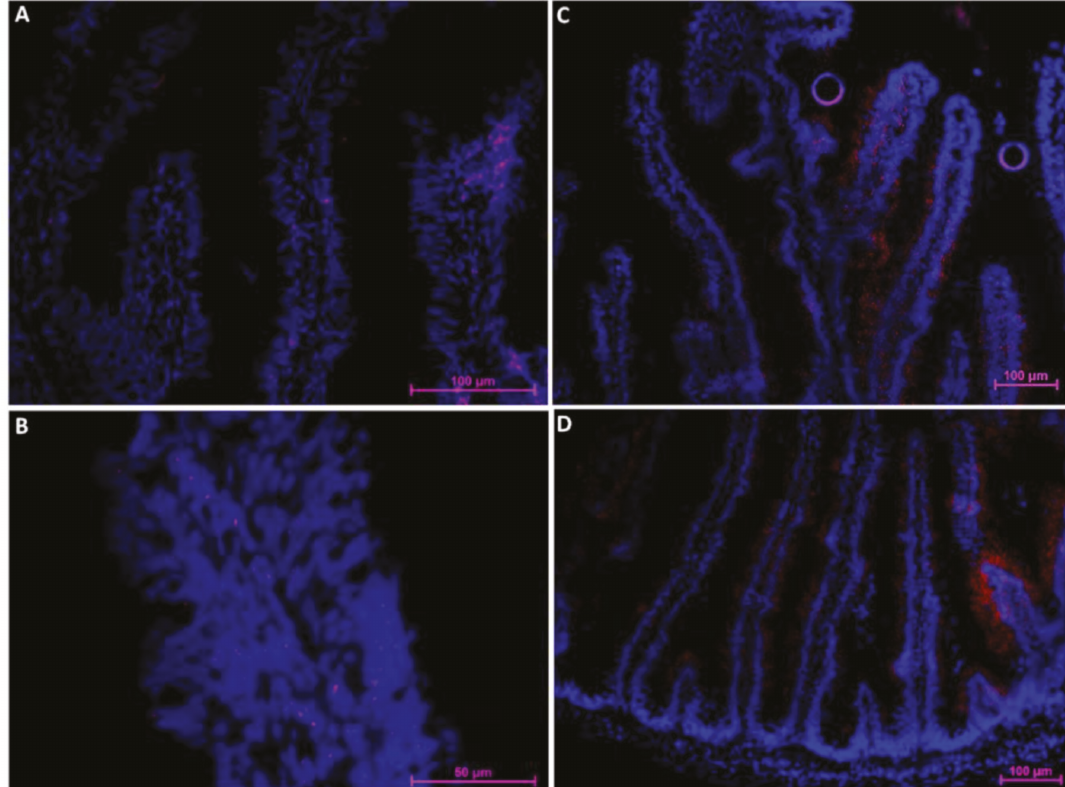
Figure 9. In situ hybridization of hopx mRNA in di ff erent segments of the rainbow trout mid-intestine (red dots). The signal was moderate in the pyloric caeca ( A ), lower in the first segment of the mid-intestine ( B , C ) and in the apical part of the complex folds of the distal, and higher in the basal part of the complex folds ( C ) and the rest of the second segment of the mid-intestine ( D ). The signal tended to disappear at the base and apex of the folds ( A , B ).